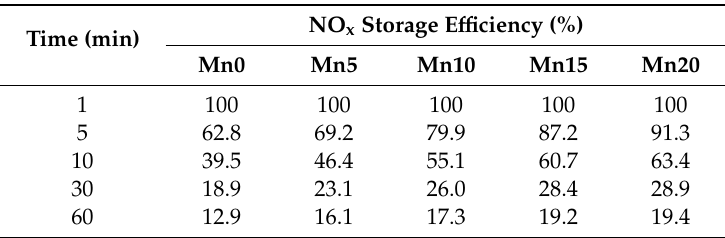
Table 4. NO x storage efficiency of the catalysts at 300 °C.